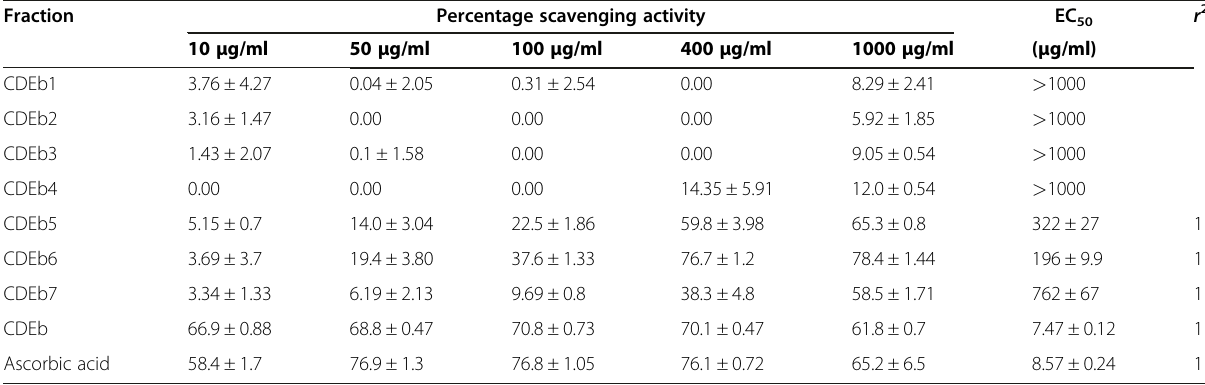
Table 4 The percentage scavenging activity of the crude DCM extract of bee pollen (CDEb) and its subfractions (CDEb1 - CDEb7) following silica gel 60 quick column chromatography